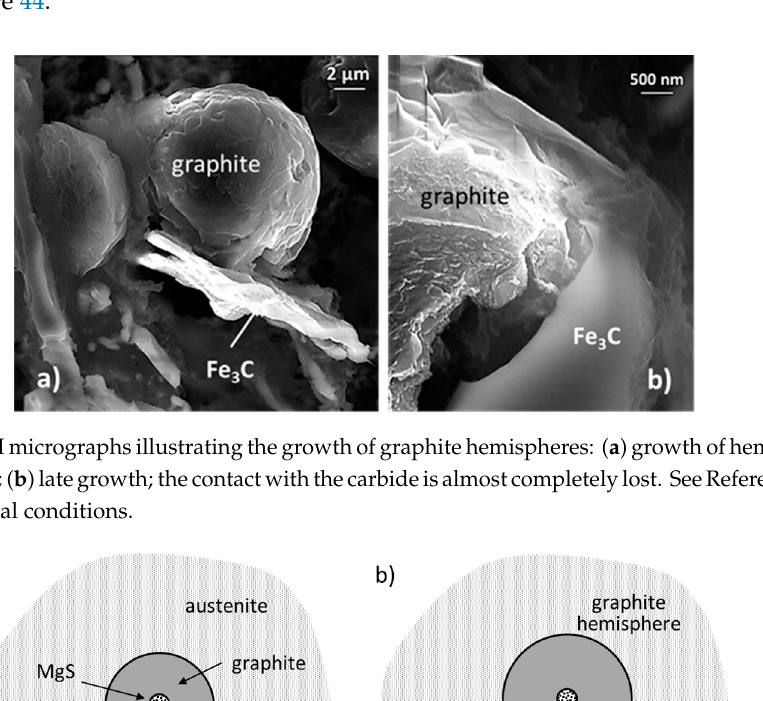
Figure 42. Graphite morphology in annealed irons with various Mg contents; ( a ) irregular graphite in no Mg iron; ( b ) skeletal-hopper graphite in 0.017% Mg iron; ( c ) hemispherical graphite in 0.047% Mg iron. See Reference [111] for experimental conditions.